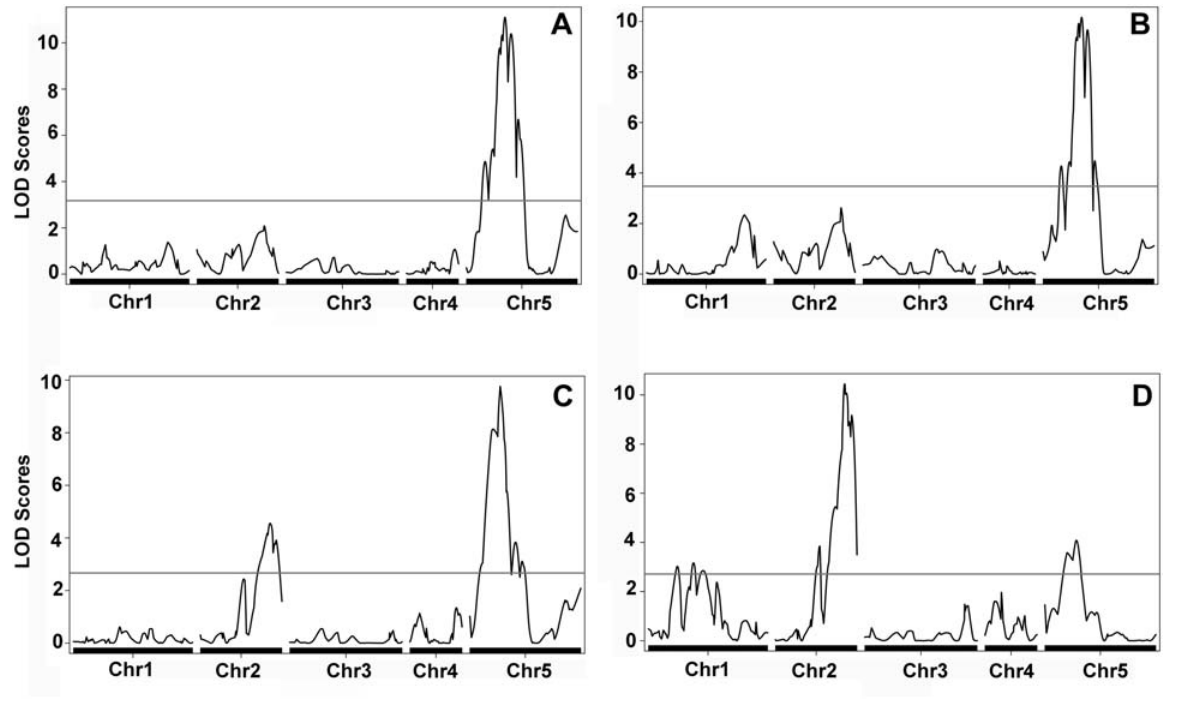
Figure 7. QTL analysis of flowering time in KendC AI-RILs. (A) QTL for days to flowering (DTF) in long days. (B) QTL for total leaf number (TLN) in long days. (C) QTL for DTF in short days. (D) QTL for TLN in short days. Note the magnitude of QTL effect changes with respect to the phenotype (DTF or TLN) in short days indicating a variation in growth.